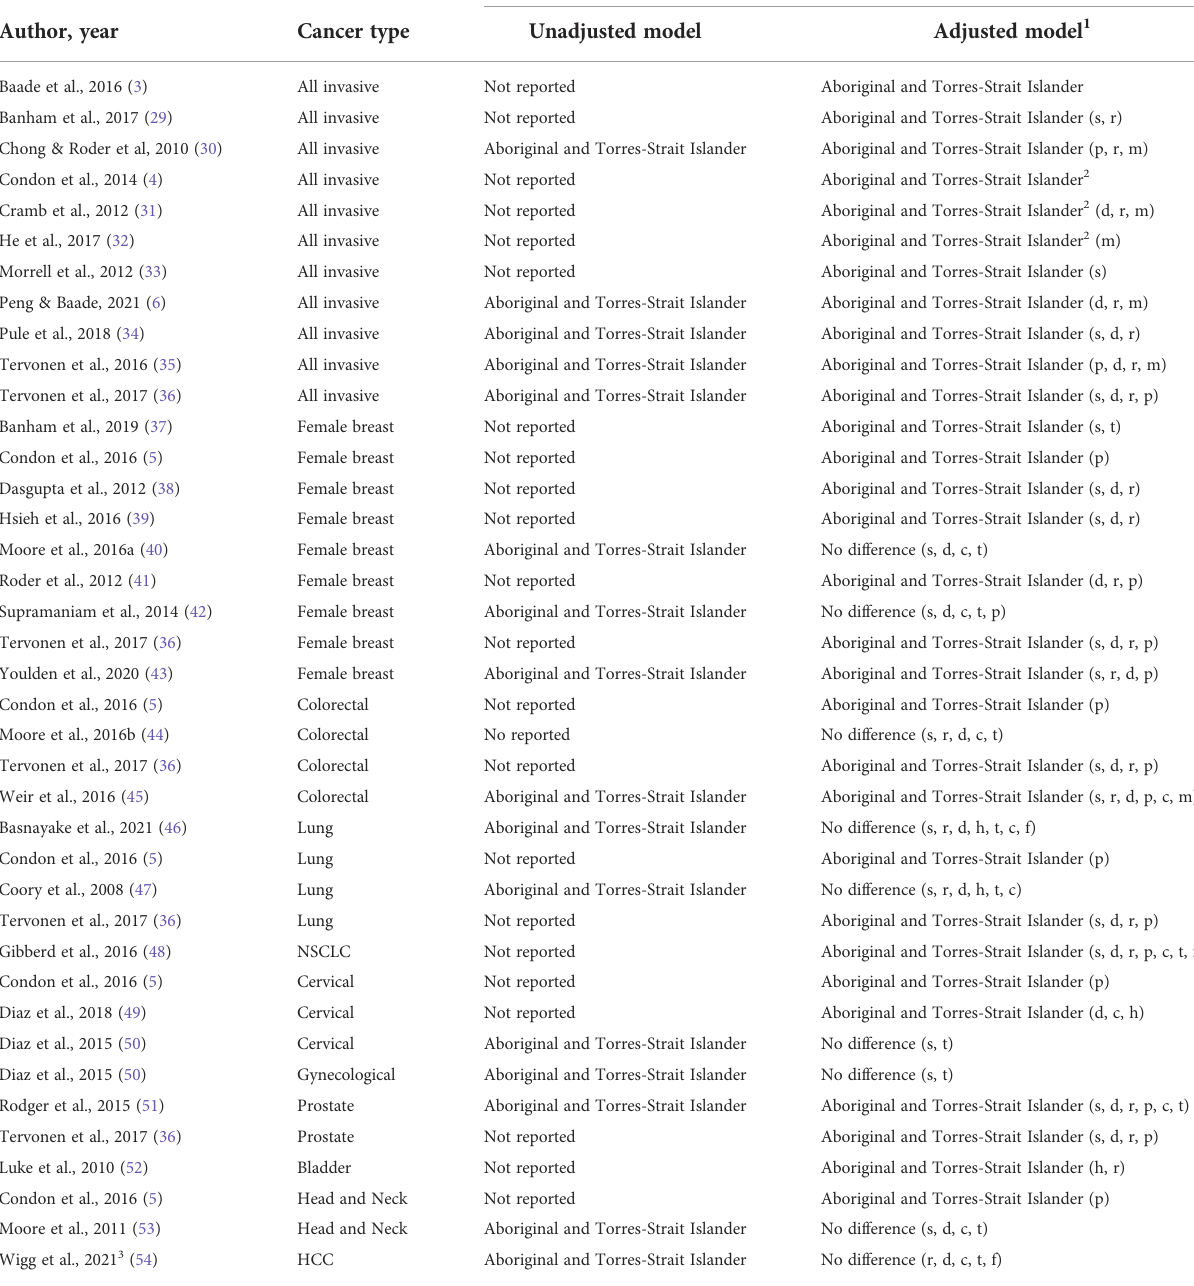
TABLE 3 Summary of Aboriginal and Torres Strait Islander survival disparity for included studies by cancer